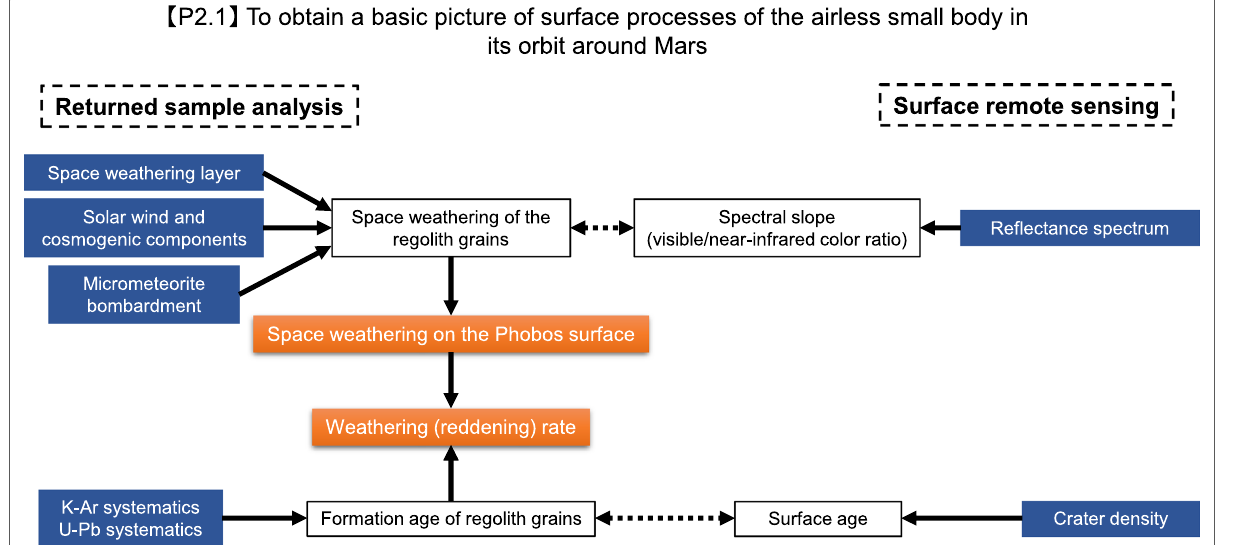
Fig. 4 Flowchart of sample analyses together with remote sensing observations to investigate the surface processes on Phobos (objective 2.1 in Table